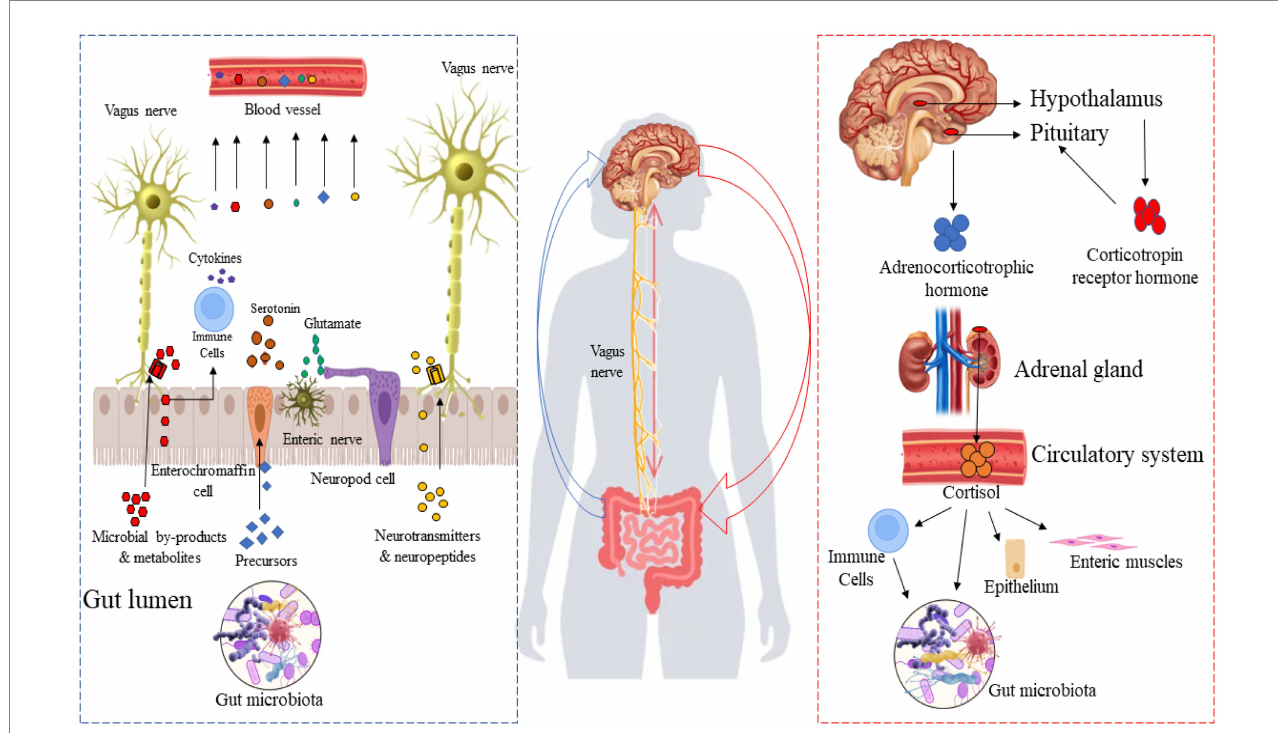
FIGURE 1 Top-down and bottom-up pathways between the gut microbiota and the brain. Right side: Gut microbiota-derived neurotransmitters and their precursor in the gut microbiome-brain axis; left side: the hypothalamus-pituitary–adrenal